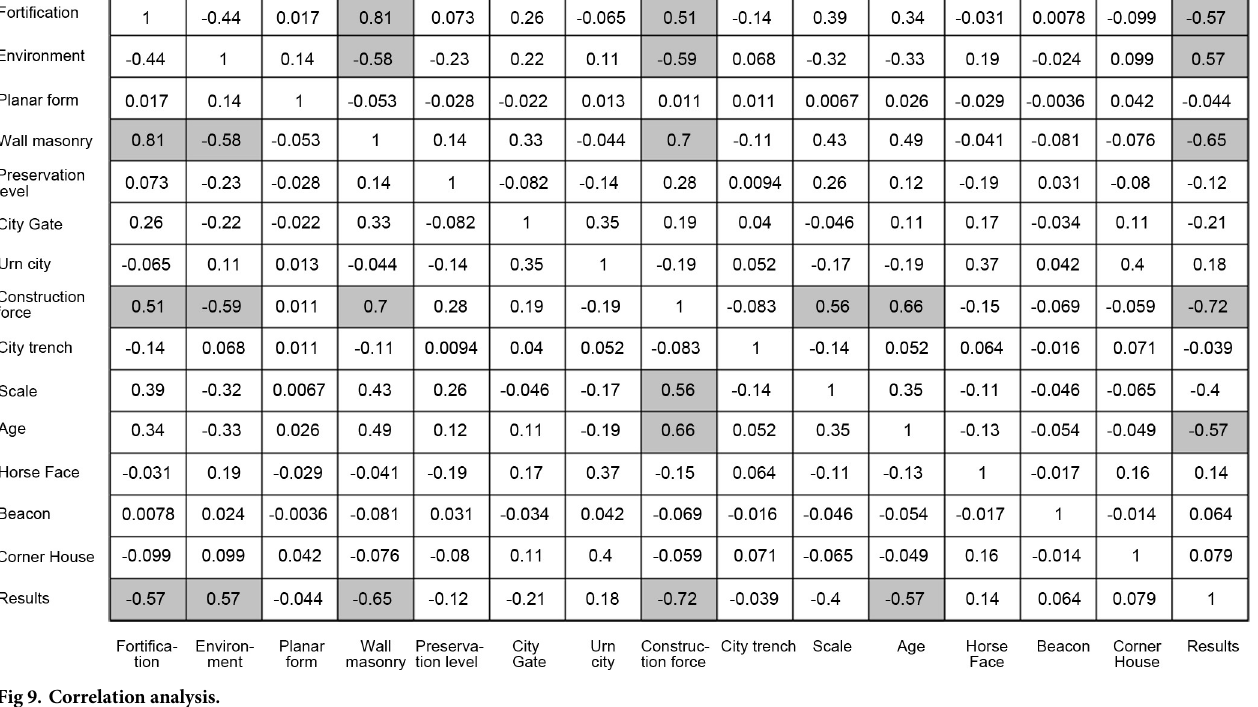
Fig 9. Correlation analysis.